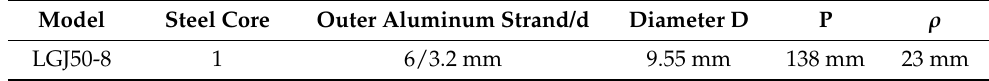
Table 2. Parameters of the power line